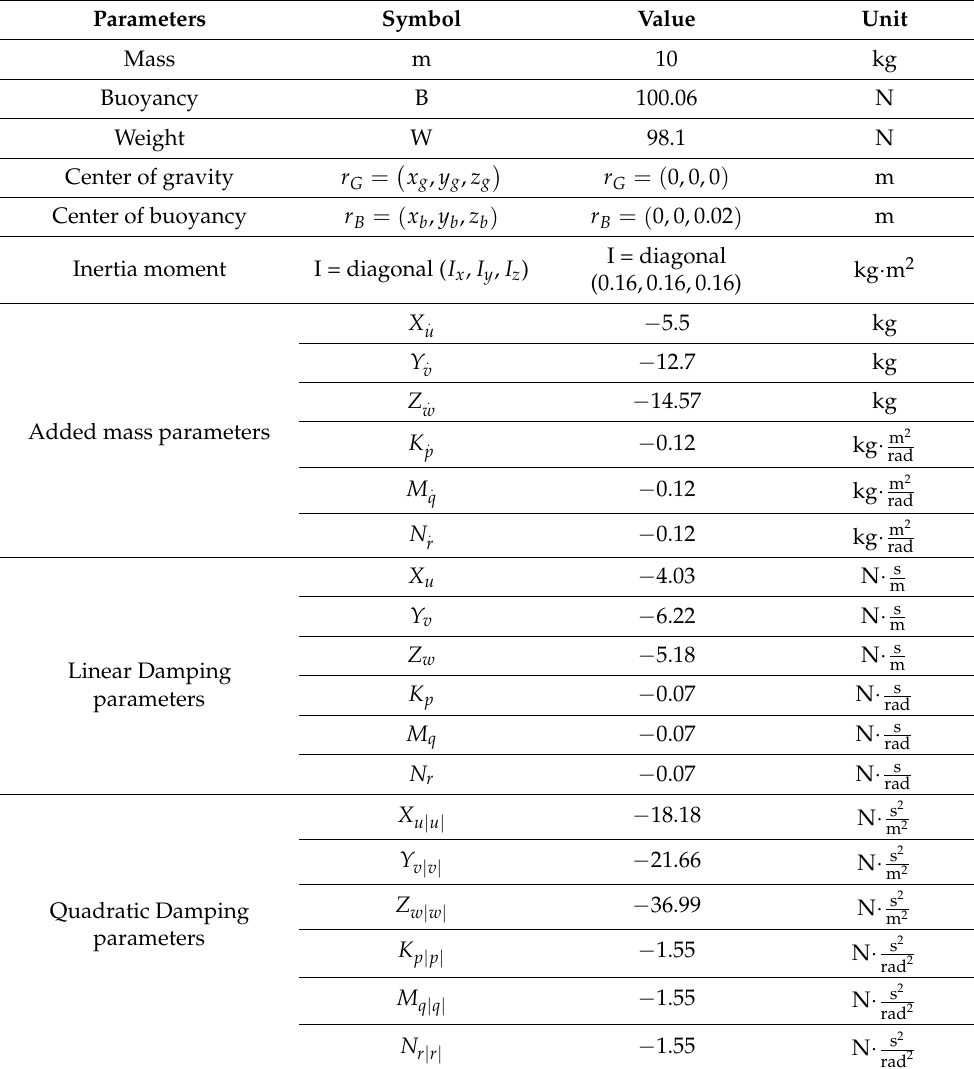
Table 2. BlueROV2